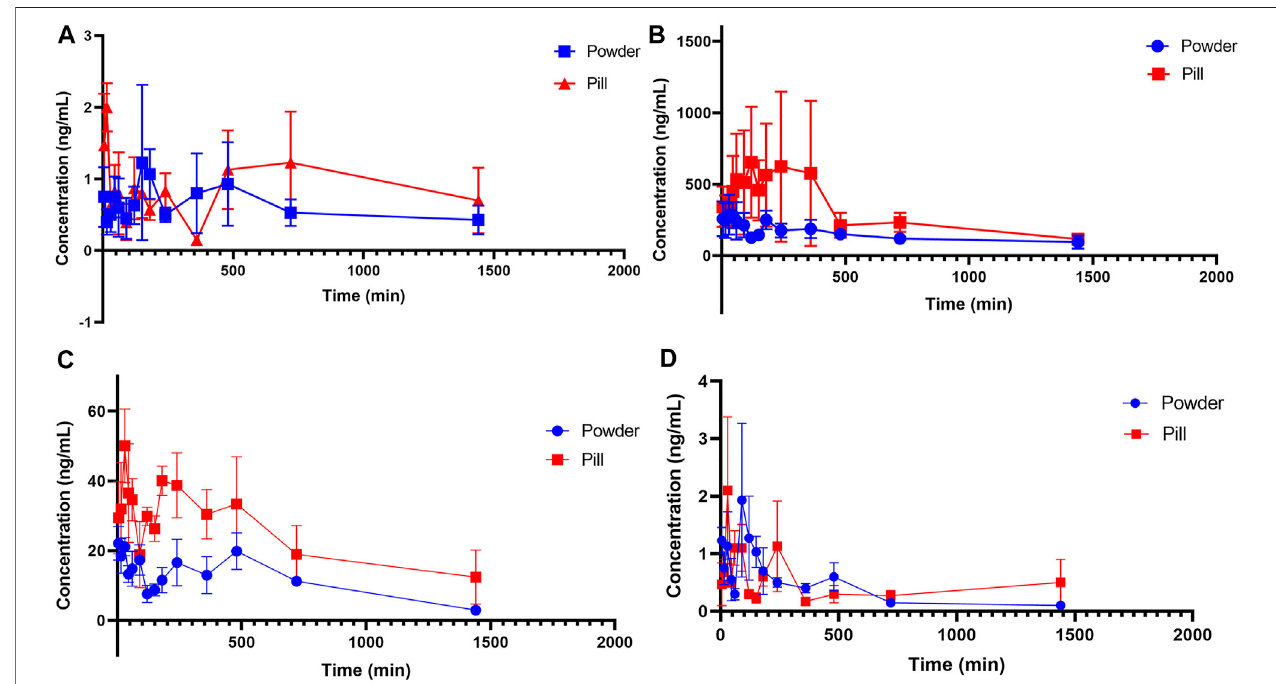
FIGURE 4 | Mean plasma concentration-time pro fi les of tetramethylpyrazine, ferulic acid, nodakenin, and isoimperatorin in the powder and pill groups. (A) Tetramethylpyrazine, (B) ferulic acid, (C) nodakenin, and (D) isoimperatorin.